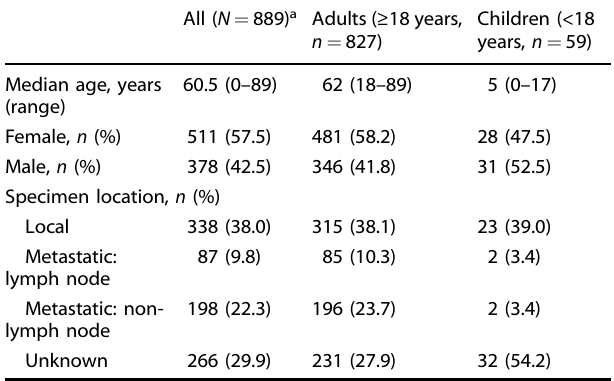
Table 1. Demographics of patients with NTRK fusion-positive tumours in